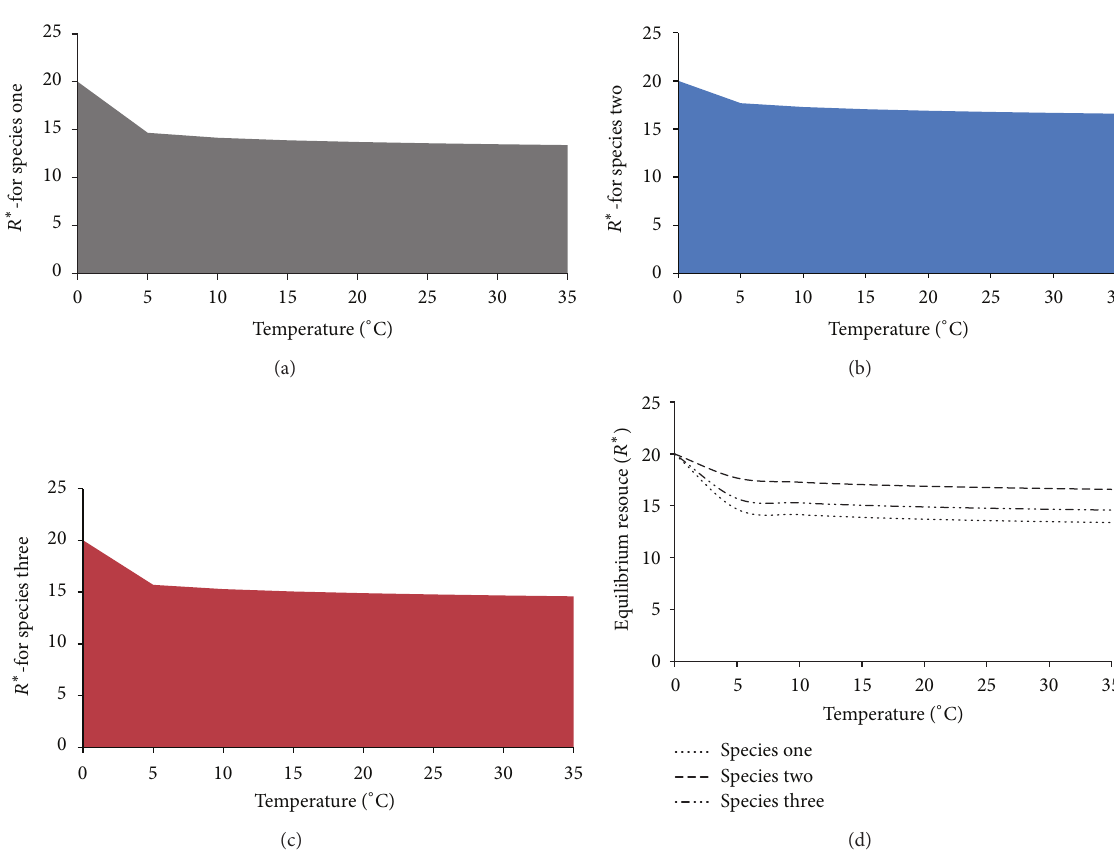
Figure 10: Temperature and equilibrium resource isoclines; curves (a)–(c) represent equilibrium boundaries of each species based on the requirements of equilibrium resource, within the unshaded region, the population size of the species will increase when it would decrease in shaded region, and (d) illustrated when three species are